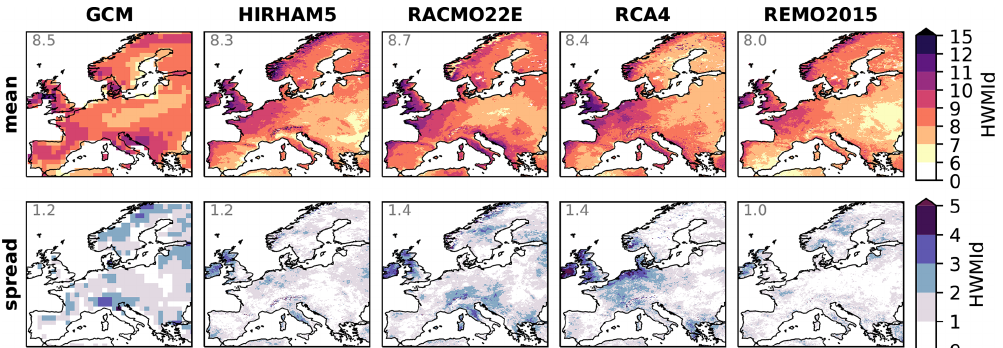
Figure 5. As Fig. 4 but for the columns of the RCM simulation matrix indicating the uncertainty associated with driving data (boundary and initial conditions). Ensemble mean and spread of the driving GCM simulations are also presented for